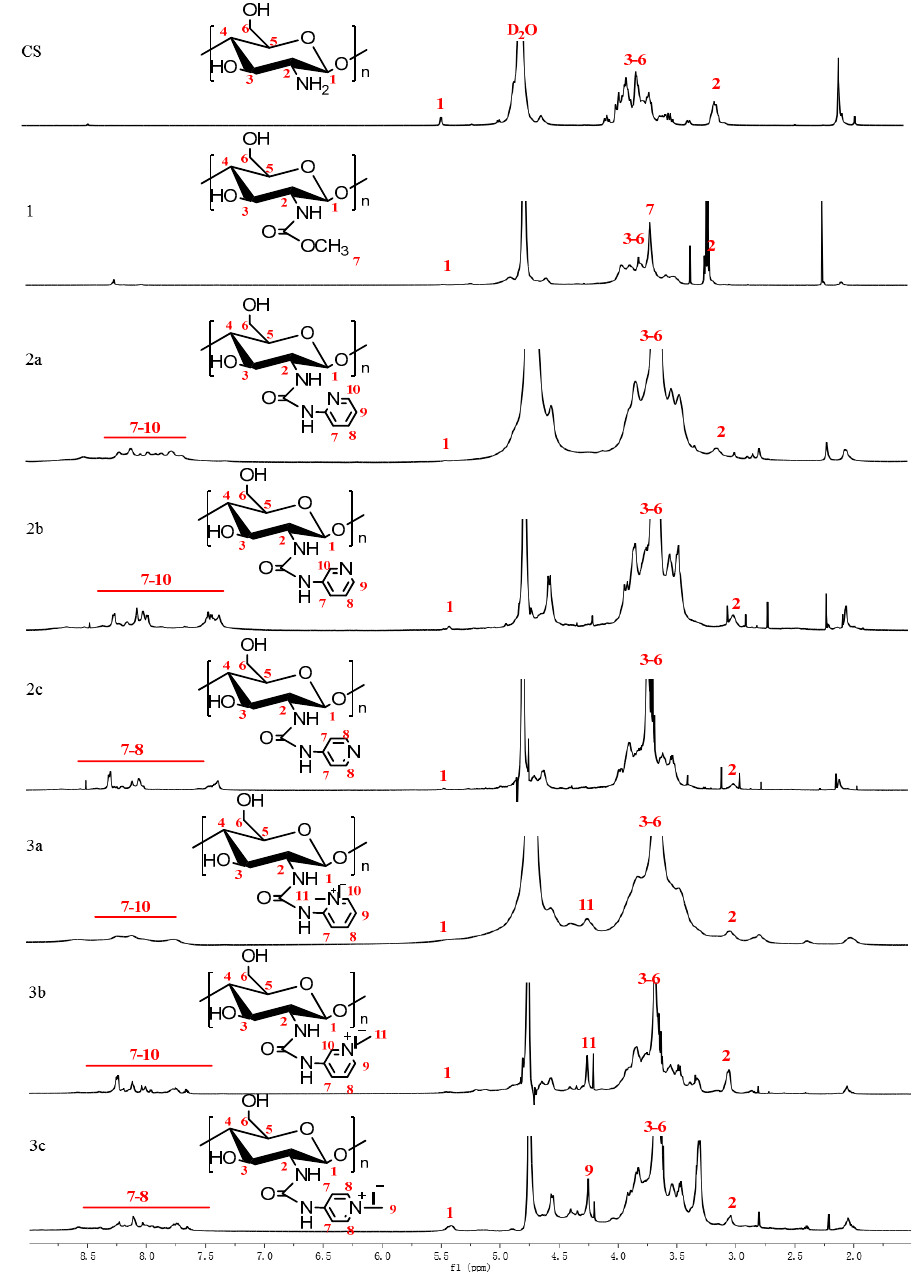
Figure 2. 1 H NMR spectra of chitosan and chitosan derivatives.